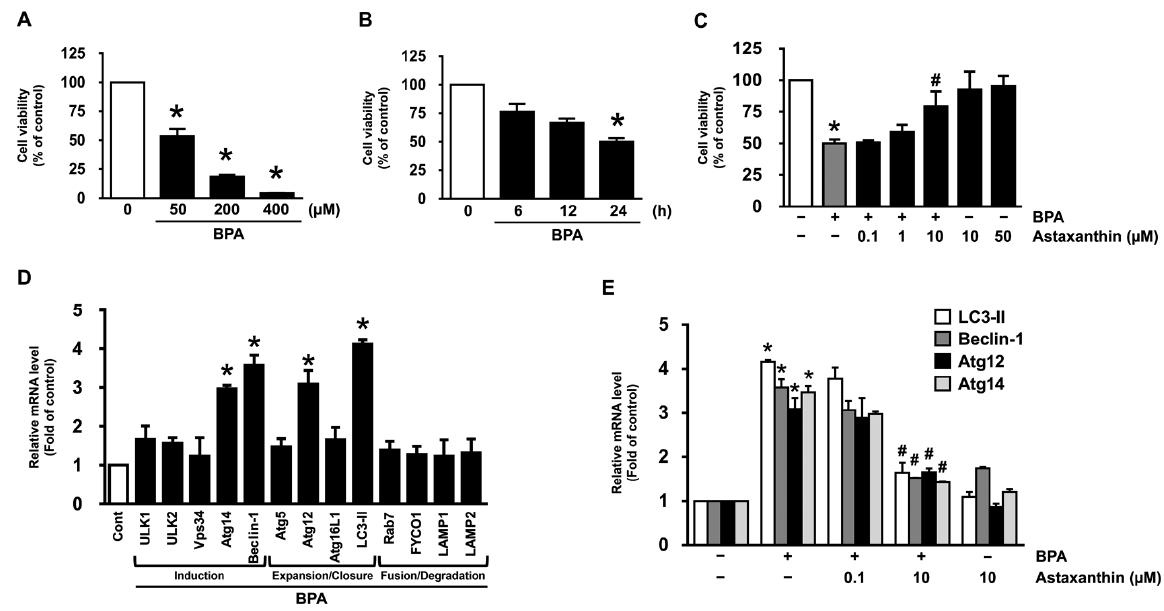
Figure 1. Inhibitory effect of astaxanthin on the dermal cell death and autophagy induced by BPA. ( A ) Dose responses of cell viability in normal human dermal fibroblasts (NHDF) treated with 50, 200, and 400 µ M of BPA for 24 h are shown. * p ≤ 0.05 versus control. n = 3. ( B ) Time responses of cell viability treated with 50 µ M of BPA for 24 h are shown. * p ≤ 0.001 versus control. n = 3. ( C ) NHDF was exposed to the BPA with astaxanthin (0.1, 1, and 10 µ M) for 24 h. * p ≤ 0.001 versus control. # p ≤ 0.05 versus BPA alone. n = 3. ( D ) NHDF was treated with BPA for 24 h. The effect of BPA on the expression of autophagy-related genes was evaluated by qRT-PCR. * p ≤ 0.05 versus control. n = 3. ( E ) NHDF was exposed to the BPA in the presence of astaxanthin (0.1 and 10 µ M) for 24 h. The mRNA level of the autophagic genes quantified by qRT-PCR is shown. * p ≤ 0.01 versus control. # p ≤ 0.01 versus BPA alone. n = 3.